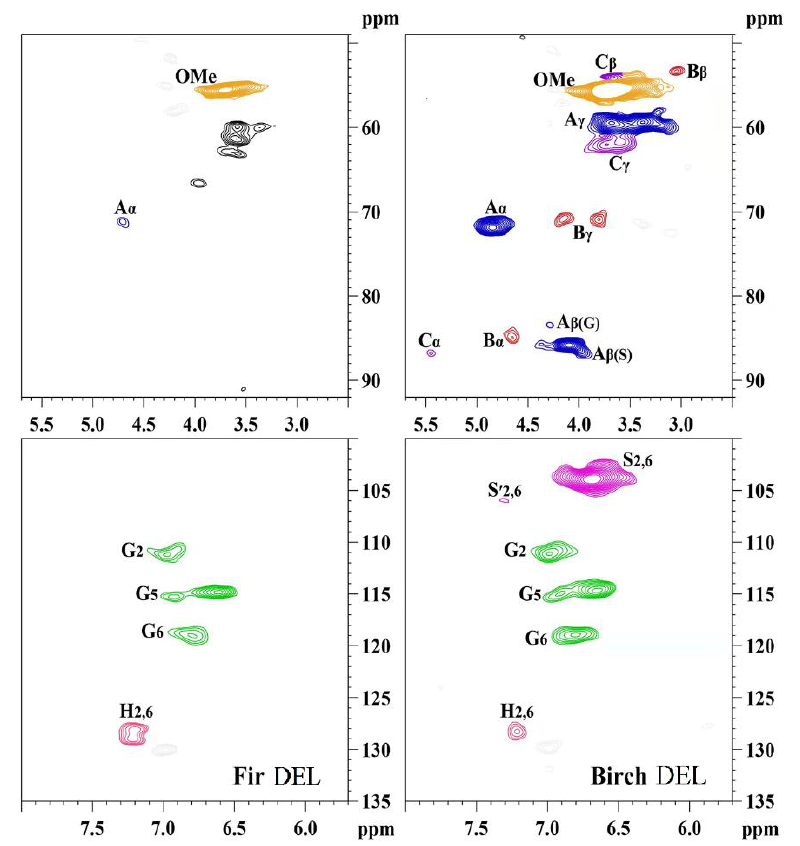
Figure 3. 2D-HSQC spectra of Chinese fir DEL and birch DEL.